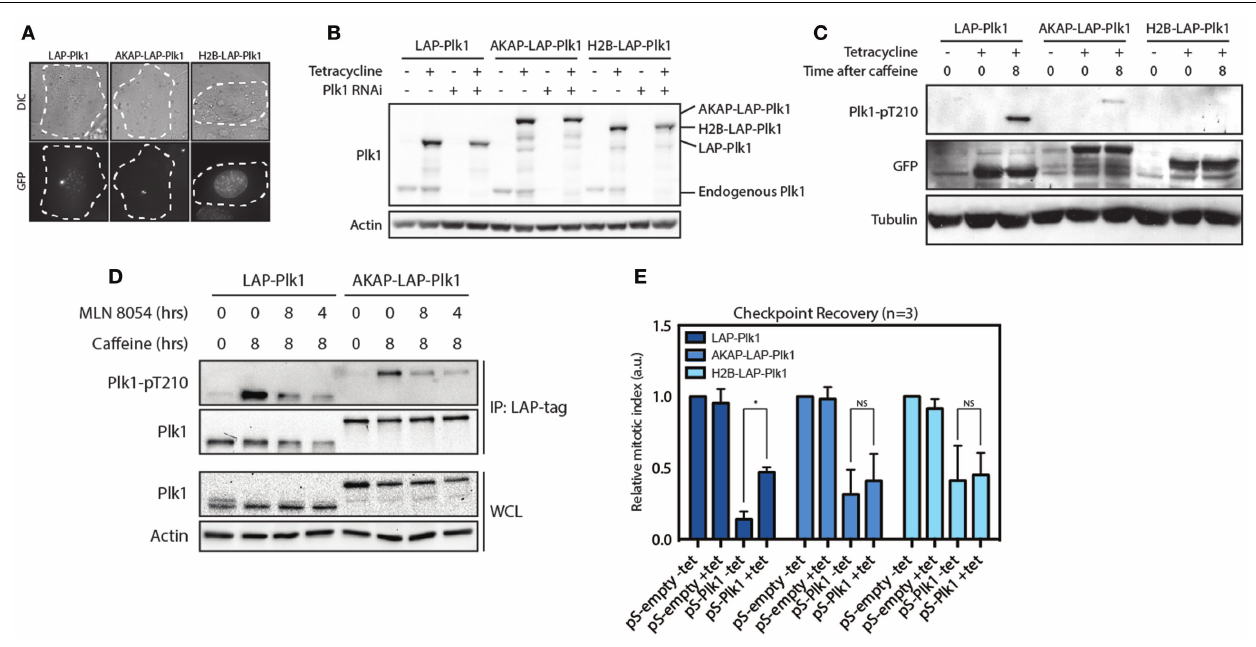
tetracycline for 16h. Cells were harvested at the indicated time points after addition of caffeine and analyzed by western blotting. (D) Cells were treated as in C. MLN 8054 was added at a concentration of 1 µ M either for 8h together with caffeine or during the last 4h of caffeine. LAP-tagged proteins were immunoprecipitated with S-protein agarose beads and analyzed by western blot. (E) Tetracycline inducible U2TR cells stably expressing RNAi resistant LAP-Plk1, AKAP-LAP-Plk1 or H2B-LAP-Plk1 were transfected with an empty pSuper, or a pSuper targeting endogenous Plk1. Cells were synchronized in G2 and damaged with 0.5 µ M adriamycin for 1h and expression was induced where indicated using tetracycline. Cells were arrested for 16h, recovery was induced by caffeine addition for 8h and the mitotic index was determined, based on the percentage of Histone H3-pS10 positive cells, using FACS. Error bars represent the SD of three independent experiments; * P <